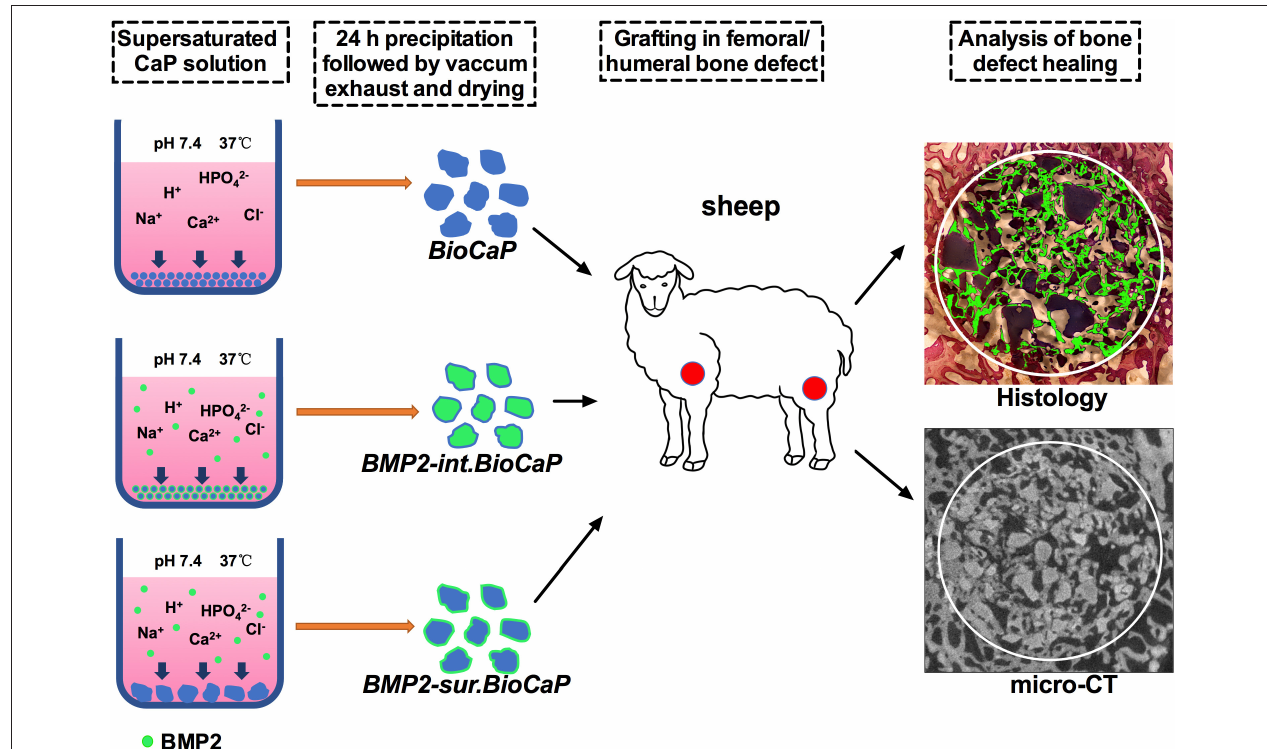
FIGURE 1 | Scheme of BMP2.BioCaP preparation and sheep femoral/humeral bone defect healing potential